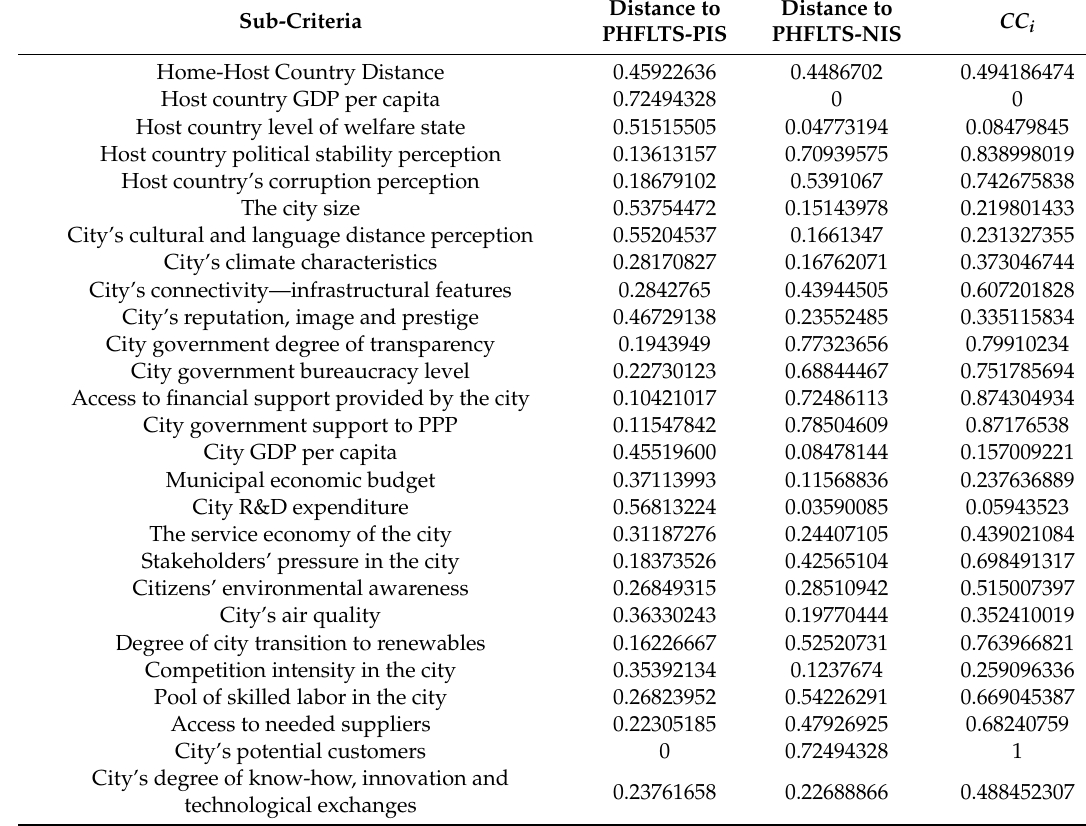
Table 6. Distances of each sub-criteria PHFLTs to the PHFLTS-PIS and to the PHFLTS-NIS and its closeness coe ffi cient ( CC i